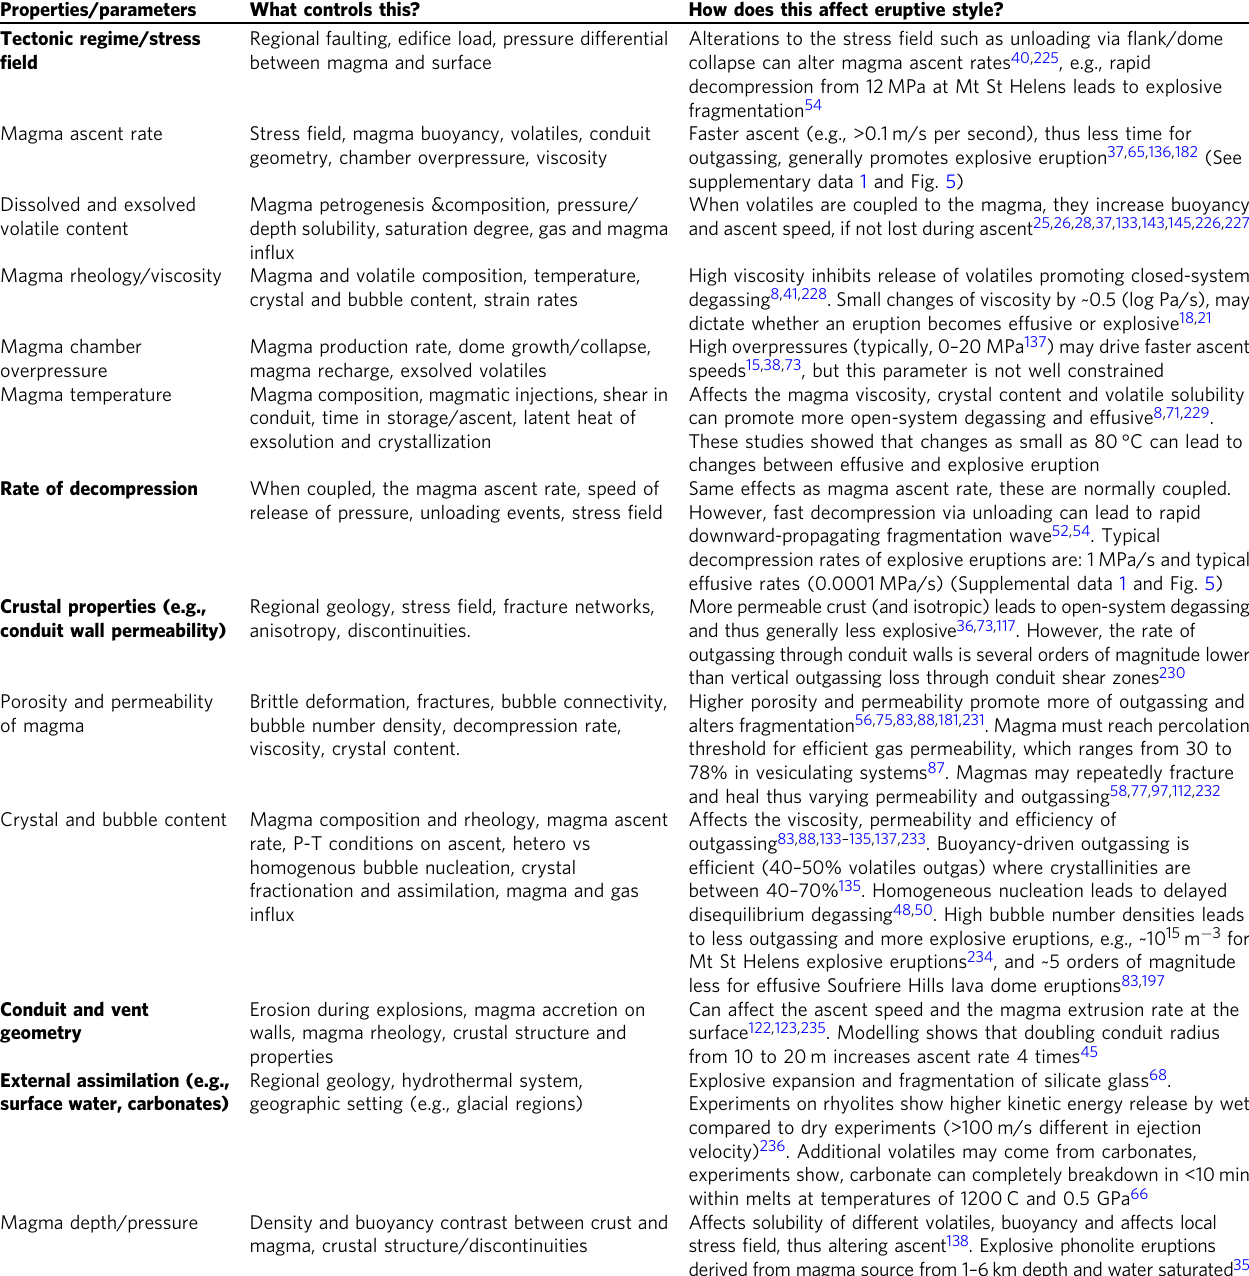
Table 1 Here, various magma properties (intrinsic) or extrinsic parameters (highlighted in bold) are given, which have been suggested to affect volcano explosivity. Their controls are given along with brief explanations of how this can affect eruptive style. Not all these references will be discussed in the text, but this serves as a reference table for the reader to seek out more detail. Deeper controls on eruptive style, not addressed in this table, include magma composition, buoyancy, and